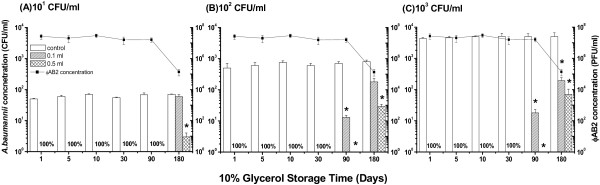
Bactericidal effect of 0.1 ml and 0.5 ml of ϕAB2-containing glycerol (stored up to 180 days) on different concentrations: (A) 101 (B) 102, and (C) 103 CFU/ml of A. baumannii M3237 contaminated agar. Phage titers (■) are shown on the right on the logarithmic scale. *p < 0.05 compared with the respective control group. “100%” indicates 100% reduction in A. baumannii M3237 following application of either 0.1 or 0.5 ml of ϕAB2-containing glycerol.